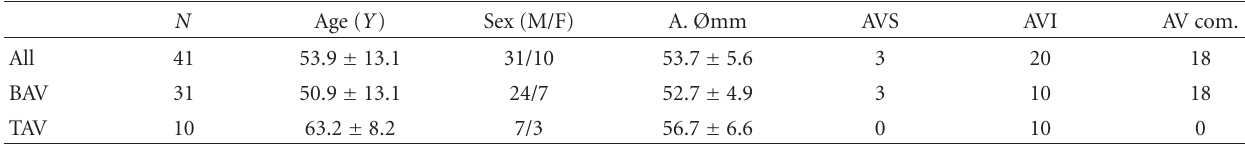
Table 1: Patient demographics and clinical characteristics.